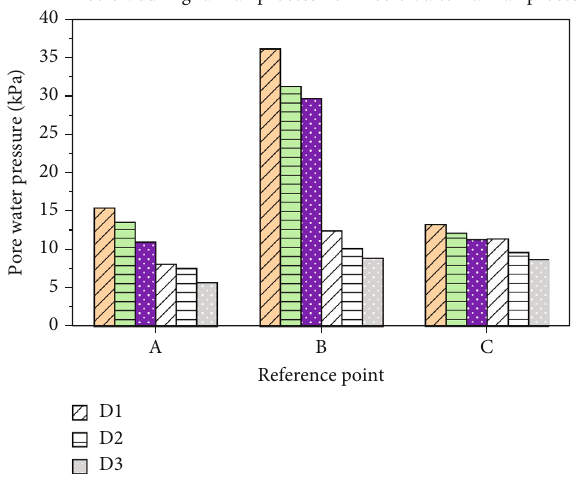
Figure 20: Di ff erent values of pore pressure at the reference points for di ff erent rooting depths.